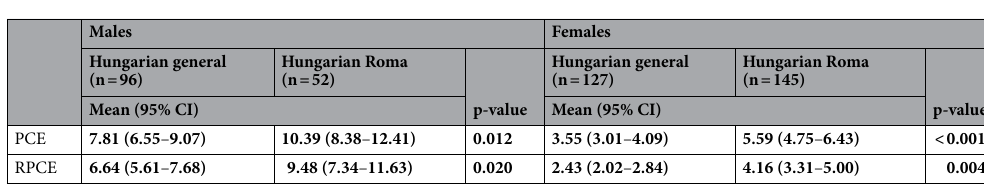
Table 6. Results obtained by using ACC/AHA pooled cohort equations (PCE) and revised pooled cohort equations (RPCE) in the 40–64-year-old Hungarian general and Hungarian Roma populations. Significant differences in mean or prevalence rates are highlighted in